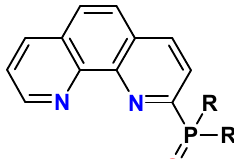
Figure 18. 2-(butylphenylphosphine oxide)-1,10-phenanthroline PhenPO. R = Bu; R′ =Ph (BuPh PhenPO ).